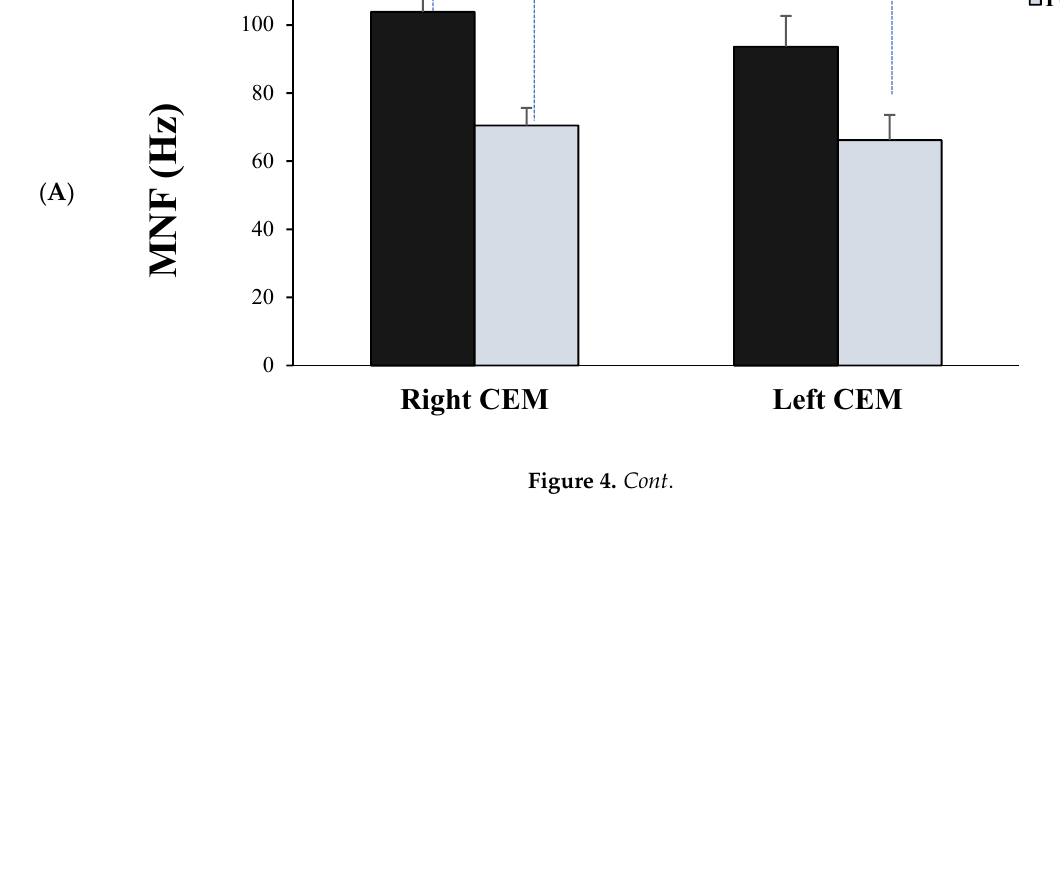
Figure 4. Average ( A ) mean power frequency (MNF), and ( B ) root mean square (RMS) for both right and left CEM during the pre and post fatigue protocol for fatigue group. Significant differences between pre and post fatigue existed for both the MNF and RMS. Error bars represent SD. * p < 0.001. 5.3. Behavioral Data There was a significant main effect of TIME (F 1,22 = 114.82, p < 0.0001, partial eta squared ( η 2 ) = 0.839) and a significant interaction of TIME by GROUP (F 1,22 = 15.239, p = 0.0001, η 2 = 0.409) for the normalized motor skill acquisition tracing data. A post hoc pair- wise comparison using the Bonferroni correction showed significant increase in accuracy for both groups following motor skill acquisition ( p = 0.0001) and at retention ( p = 0.0001), with the control group demonstrated a greater improvement after both motor skill acqui- sition (F 1,22 = 23.55, p = 0.0001, η 2 = 0.517) and at retention (F 1,22 = 12.78, p = 0.002, η 2 = 0.368), (27% and 37%), as compared to the fatigue group (4% and 26%), respectively (Figures 5 and 6).